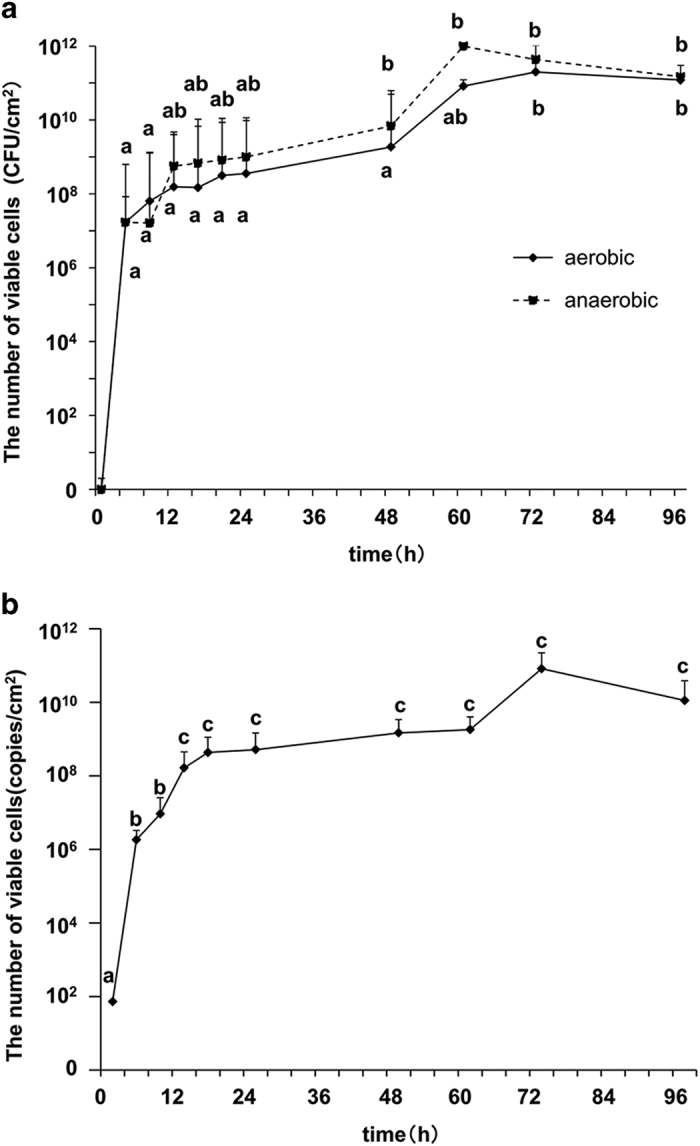
Quantification of biofilm-forming cells. (a) Viable bacterial cell count per unit area. Solid and dashed lines indicate bacteria incubated under aerobic or anaerobic conditions, respectively. The letters a and b represent a significant difference between the opposing letters (P<0.05). Significant differences in the numbers of bacteria incubated under aerobic or anaerobic conditions are shown below the solid line and above dotted line, respectively. (b) Real-time PCR analysis of biofilm-forming cells. The letters a, b and c represent significant difference between the opposing letters (one-way analysis of variance, Tukey–Kramer test, P<0.05). Data are presented as the mean±s.e.m. (n=10).